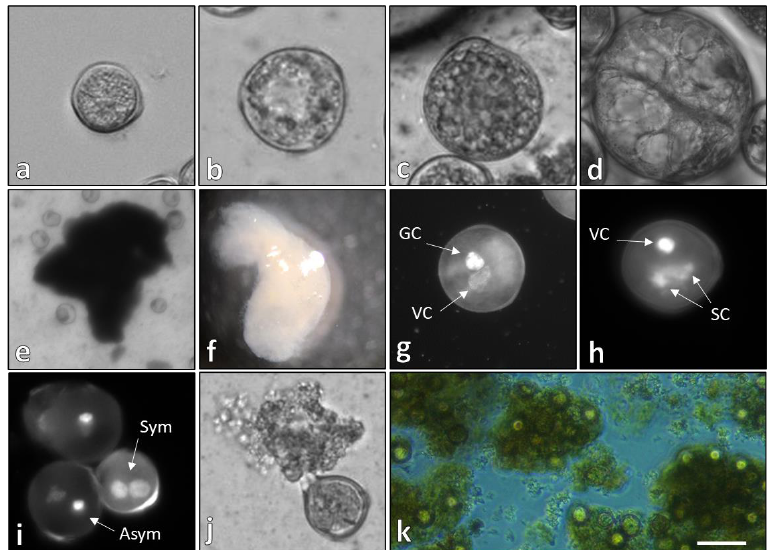
Figure 1. In vitro development of temperature-stressed soybean microspores. ( a – c ) Microgametogenesis, denoted by cell enlargement and the presence of starch granules; ( d – f ) microspore embryogenesis in soybean. ( d ) Embryogenic microspore with evident cytoskeletal fibers fragmenting the cytoplasm; ( e ) rapidly dividing pro-embryo; ( f ) microspore-derived embryo with established polarity; ( g , h ) pollen mitosis 1 ( g ) and 2 ( h ) observed in noninduced microspores; ( i – k ) cytological markers associated with an embryogenic culture. ( i ) Symmetrical division during pollen mitosis 1 observed via DAPI staining; ( j , k ) secretion of intrinsic molecules from nonisodiametric cells into the induction medium, forming a matrix. VC = vegetative cell; GC = generative cell; SC = sperm cell; Sym = symmetrical mitotic division; Asym = asymmetrical mitotic division. ( a – c ) bars = 15 μm ; ( d ) 5 μm ; ( e ) 100 μm ; ( f ) 1 mm; ( g , h ) 10 μm ; ( i , j ) 15 μm ; ( k ) 100 μm.